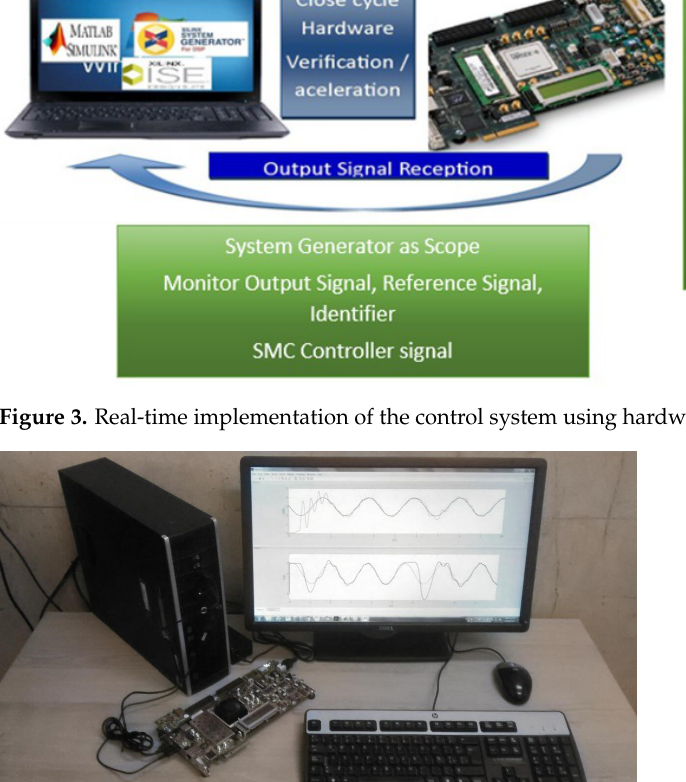
Figure 4. Physical real-time implementation using hardware-in-loop architecture.